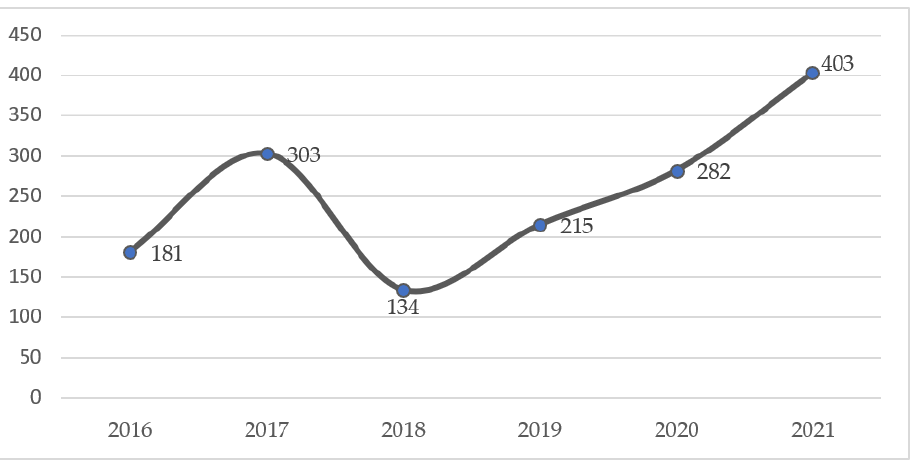
Figure 1. The number of detected victims of trafficking per year in Turkey. Source: PMM (2022), Available online https://en.goc.gov.tr/victims-of-human-trafficking2019 (accessed on October 6, 2022).